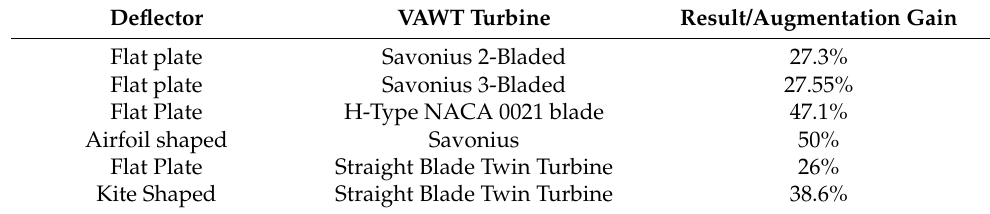
Table 3. Comparison of the types of wind deflectors and VAWTs in terms of performance gain.